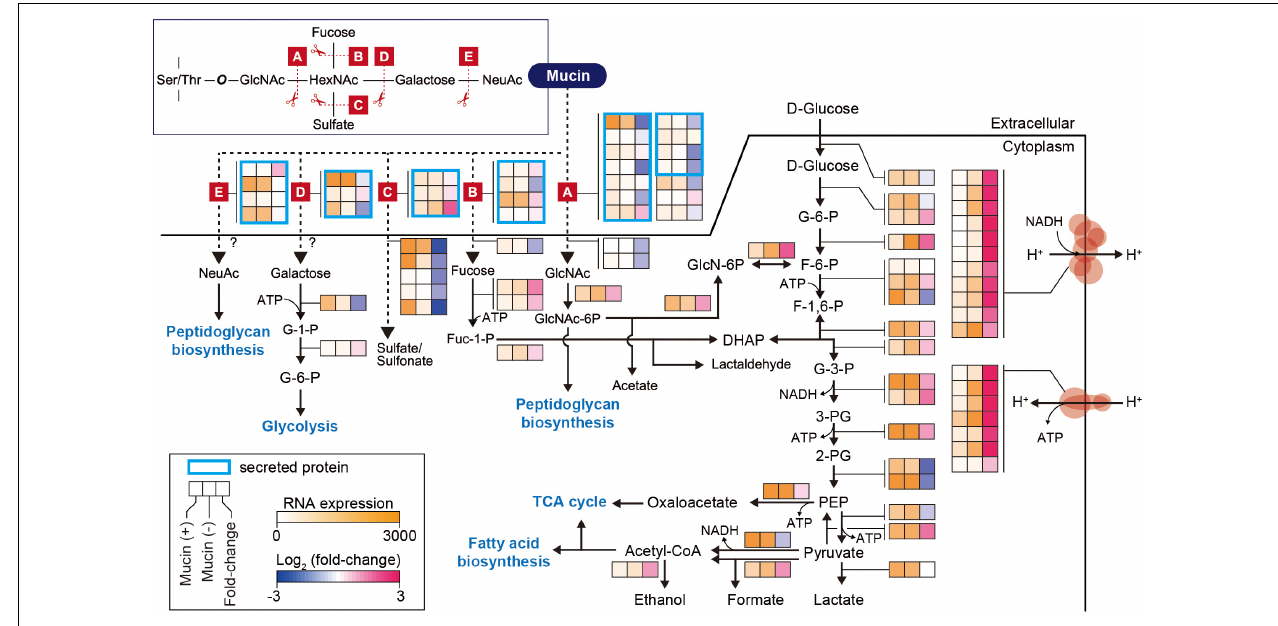
FIGURE 2 | Differentially expressed genes involved in mucin-degradation pathway and glycolytic/gluconeogenesis in A. muciniphila . Enzymes are represented according to their corresponding mucin-degrading reactions, as follows: A, N -acetylgalactosaminidase; B, L -fucosidase; C, sulfatase; D, galactosidase; E, neuraminidase. The heat map indicates RNA expression levels and log 2 fold changes. Gene list and expression values are also shown in Supplementary Table S4 .